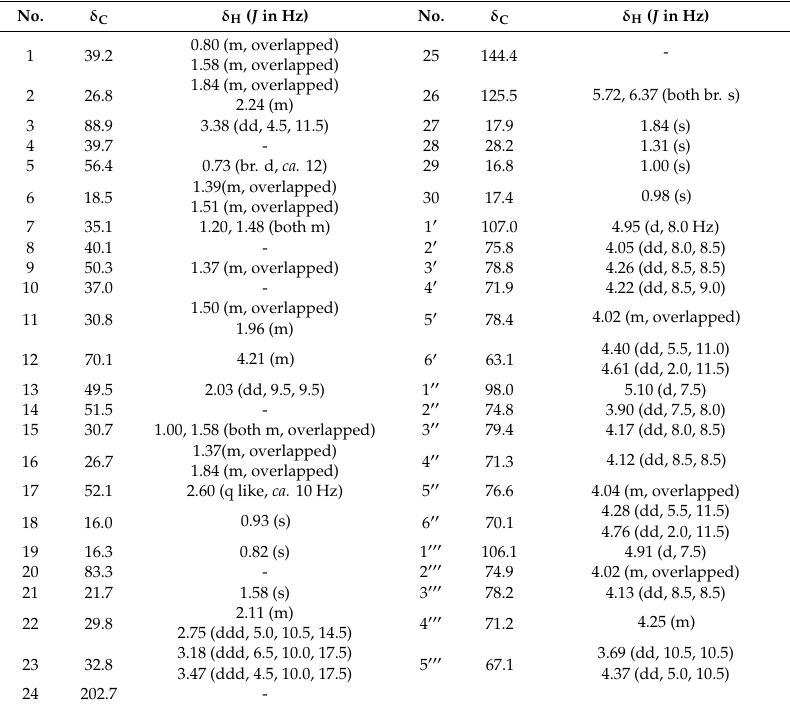
Table 9. The 1 H and 13 C-NMR data for 9 in C 5 D 5 N